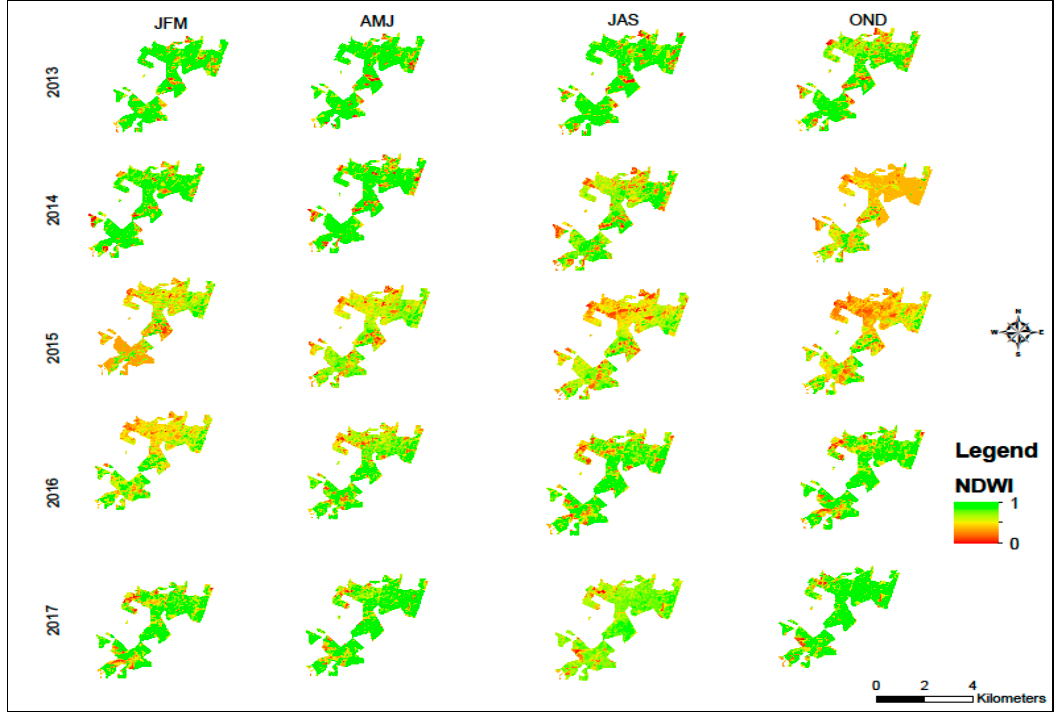
Figure 8. The spatial pattern of quarterly NDWI values over KwaMbonambi from 2013 to 2017.